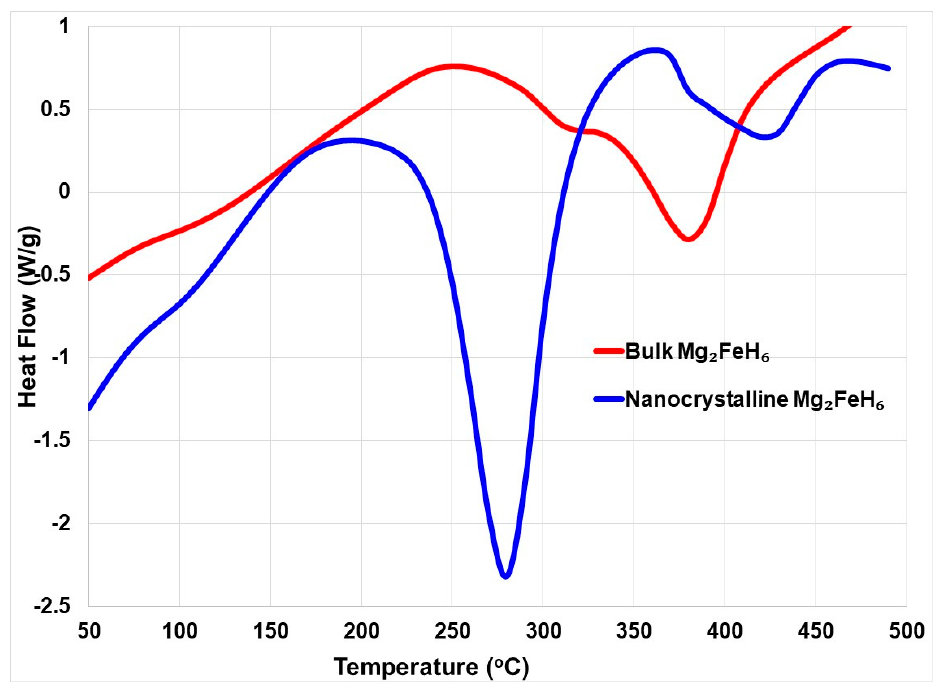
Figure 7. DSC curves of Mg 2 FeH 6 in its bulk and nanocrystalline forms.